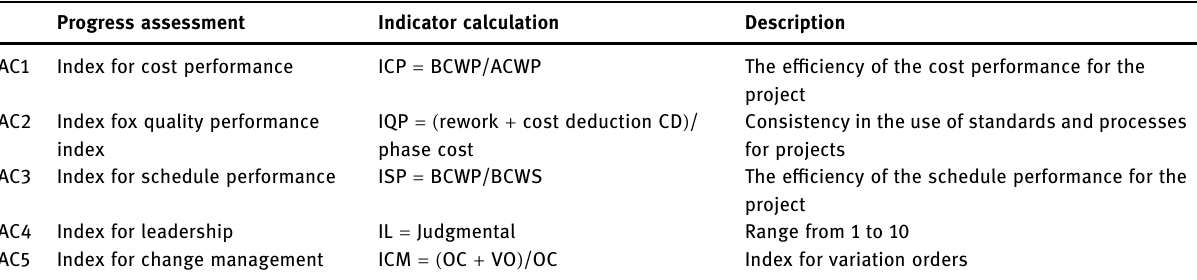
Table 6: Indicators calculation for the project performance Progress